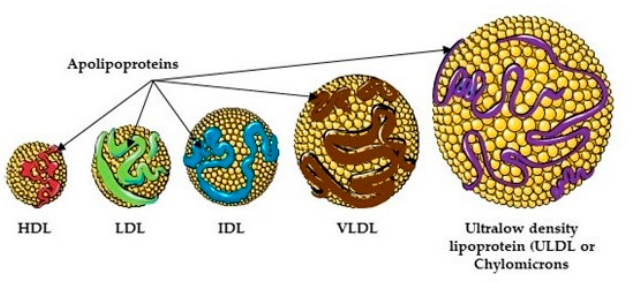
Figure 2. Lipoprotein—types and function. Four kinds of lipoproteins exist in the human body viz. high density lipoprotein (HDL), low density lipoprotein (LDL), very low density lipoprotein (VLDL) and one intermediate product, intermediate density lipoprotein. Nomenclature is based on the ratio of their size and density (g/dL): HDL (7–13 nm in diameter, 1.063–1.25), LDL (22–27 nm, 1.019–1.063), ILDL (27–30 nm, 1.006–1.019), VLDL (35–80 nm, 0.95–1.006), chylomicrons (80–1200 nm, <0.95). Their function is determined by the apolipoproteins on their surface. Major apolipoproteins present on lipoproteins include A-I, A-II, C, E in HDL (orange), B-100 in LDL (green); B-100, C, E in LDL (blue), and VLDL (brown) and B-48, A-I, A-II, C, E in chylomicrons (purple). HDL removed cholesterol from peripheral tissue, LDL delivers fat to peripheral tissue, IDL and VLDL transport fats from the liver, while chylomicrons transport dietary fats (food and bile). Figure produced using Servier medical art [54].